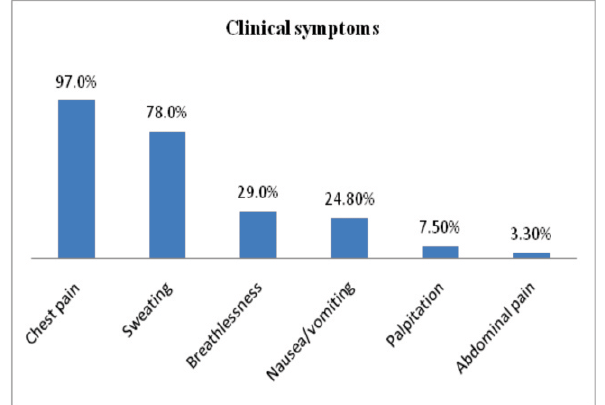
Figure 1: Clinical symptoms of patients with ST-